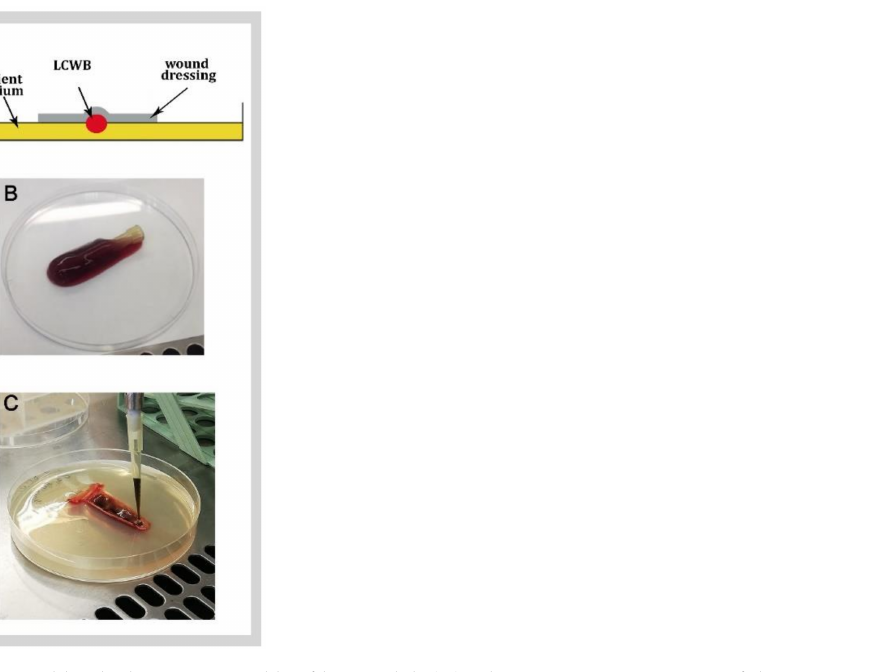
Figure 2. Lubbock chronic wound biofilm model: ( A ) schematic representation of the treatment of LCWB transferred to artificial wound bed, adapted from Kucera et al. [60]; ( B ) mature LCWB of S. aureus and P. aeruginosa grown together; ( C ) antimicrobial application in a LCWB model located in an artificial wound